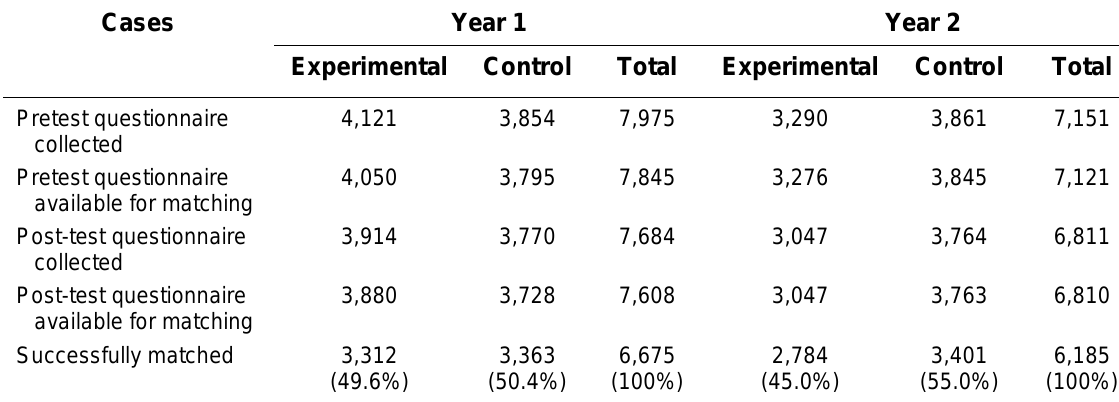
Number of Participants and Completed Questionnaires Collected at Year 1 (Waves 1 and 2)